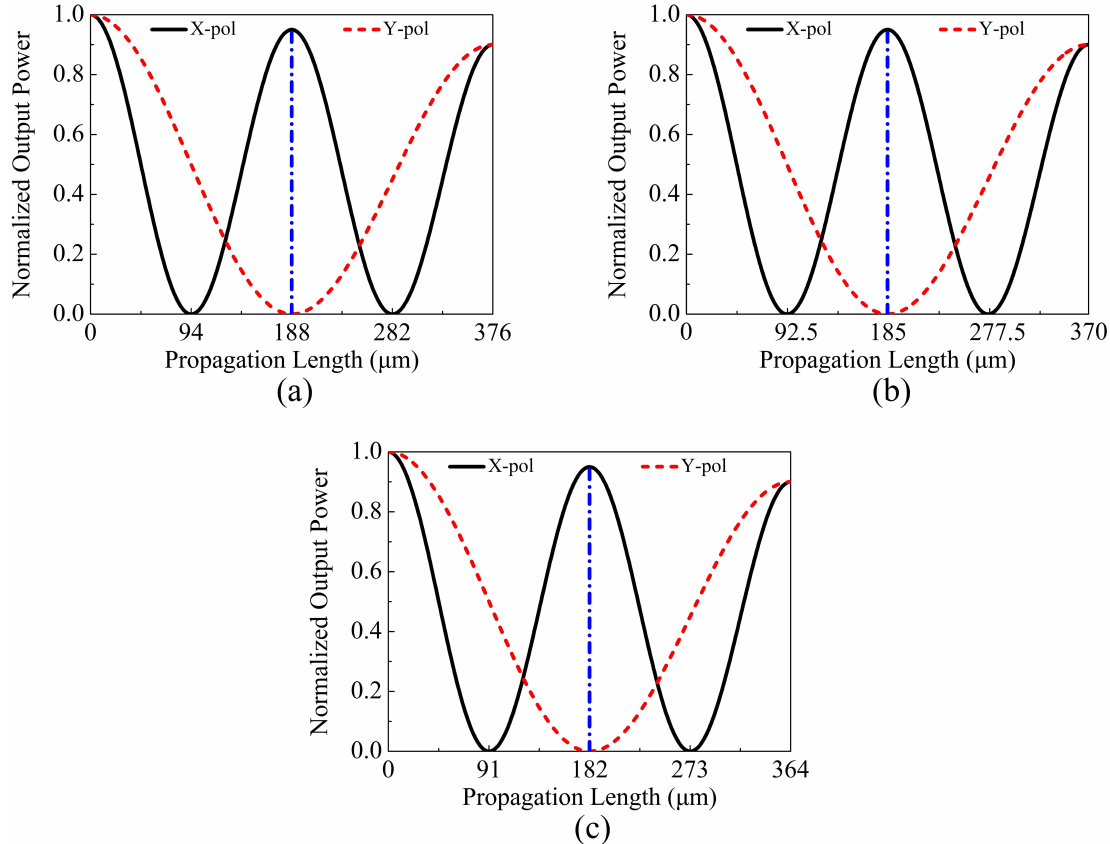
Figure 11. The relationships between the output powers P out of the X and Y-pol of the proposed V-DC-PCF PBS and PL at the three wavelengths ( a ) 1.610, ( b ) 1.631, and ( c ) 1.650 µ m,